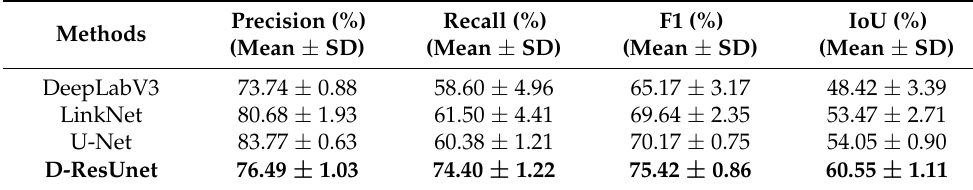
Table 6. Precision, Recall, F1, and IoU of the models (Mean ± SD 1 ).